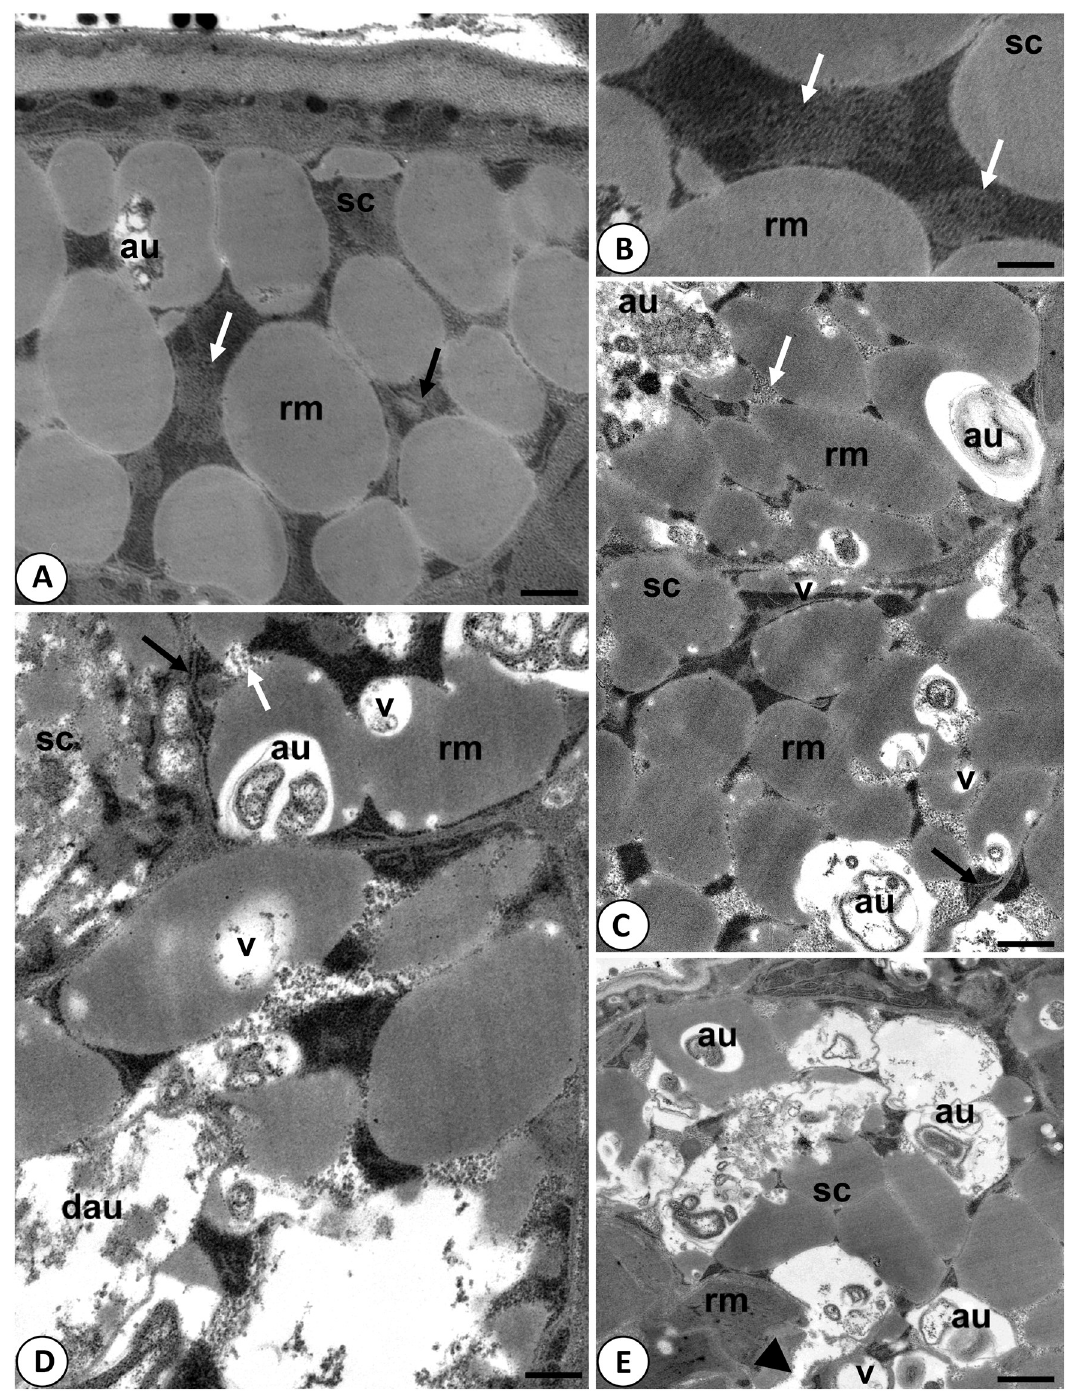
Fig 3. Ultrastructure of storage cells in tuns of Hys . exemplaris . A-B . Storage cells in stage 0—cells with no signs of degeneration: au–autophagosome rm- reserve material, sc—storage cell, black arrow—cisternae of rough endoplasmic reticulum, white arrow— mitochondrion; A . scale = 0.38 μ m; B . scale = 0.23 μ m; C . Storage cells in stage 1– cells with the first signs of degeneration: au– autophagosome rm- reserve material, sc—storage cell, v- vacuole, black arrow—cisternae of rough endoplasmic reticulum, white arrow—mitochondrion; scale = 0.41 μ m; D-E . Storage cells in stage 2– cells with highly advanced degeneration: au–autophagosome, dau—disintegrated autophagosome, rm- reserve material, sc—storage cell, v–vacuole, black arrow—cisternae of rough endoplasmic reticulum, white arrow—mitochondrion, arrowhead–degraded cell membrane; D . scale = 0.29 μ m; E . scale = 0.56 μ m (see also Table 2).